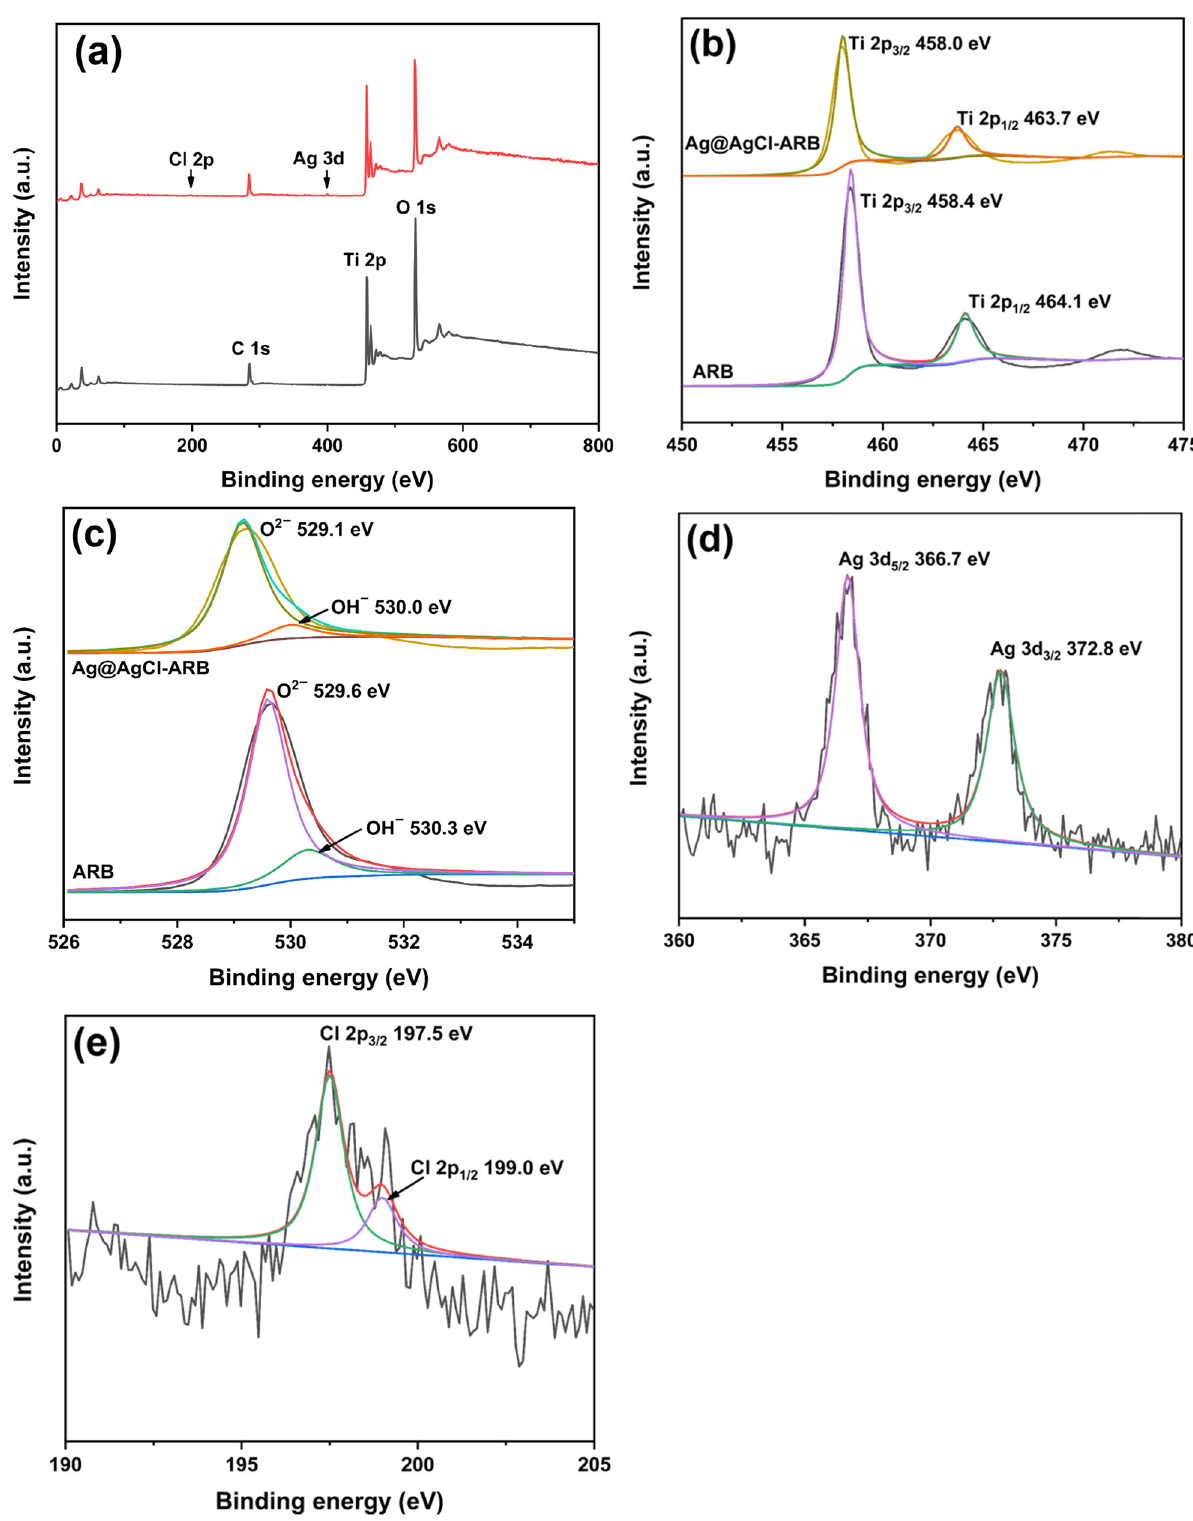
Figure 4: XPS survey of ARB and Ag@AgCl – ARB ( a ) , high resolution spectra of Ti 2p ( b ) , O 1 s ( c ) , Ag 3d ( d ) , and Cl 2p ( e )